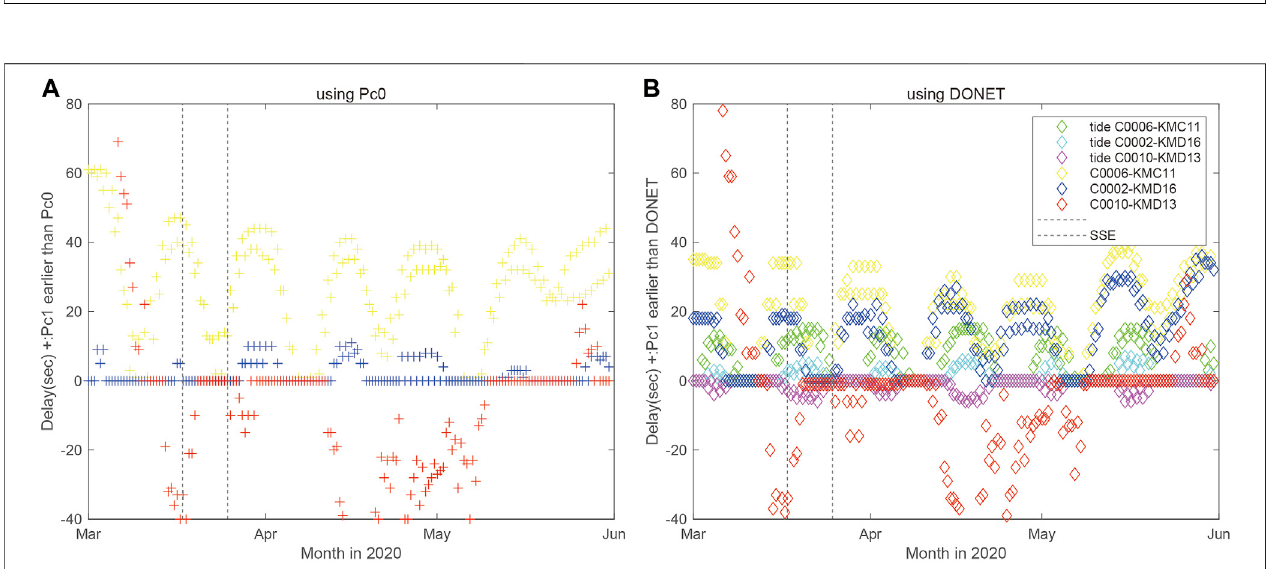
FIGURE3| Timeseriesoffactor α forsuccessiveintervalsof12.42 hatC0002(blue),C0010(red),andC0006(yellow).Thereferencepressuresonthesea fl oorare assumed tobe (A) Pc0 and (B) thenearestDONETstation (KMD16 forC0002;KMD13forC0010;KMC11 forC0006),respectively. Twoverticallines indicate theonset and termination time of the SSE that occurred in March